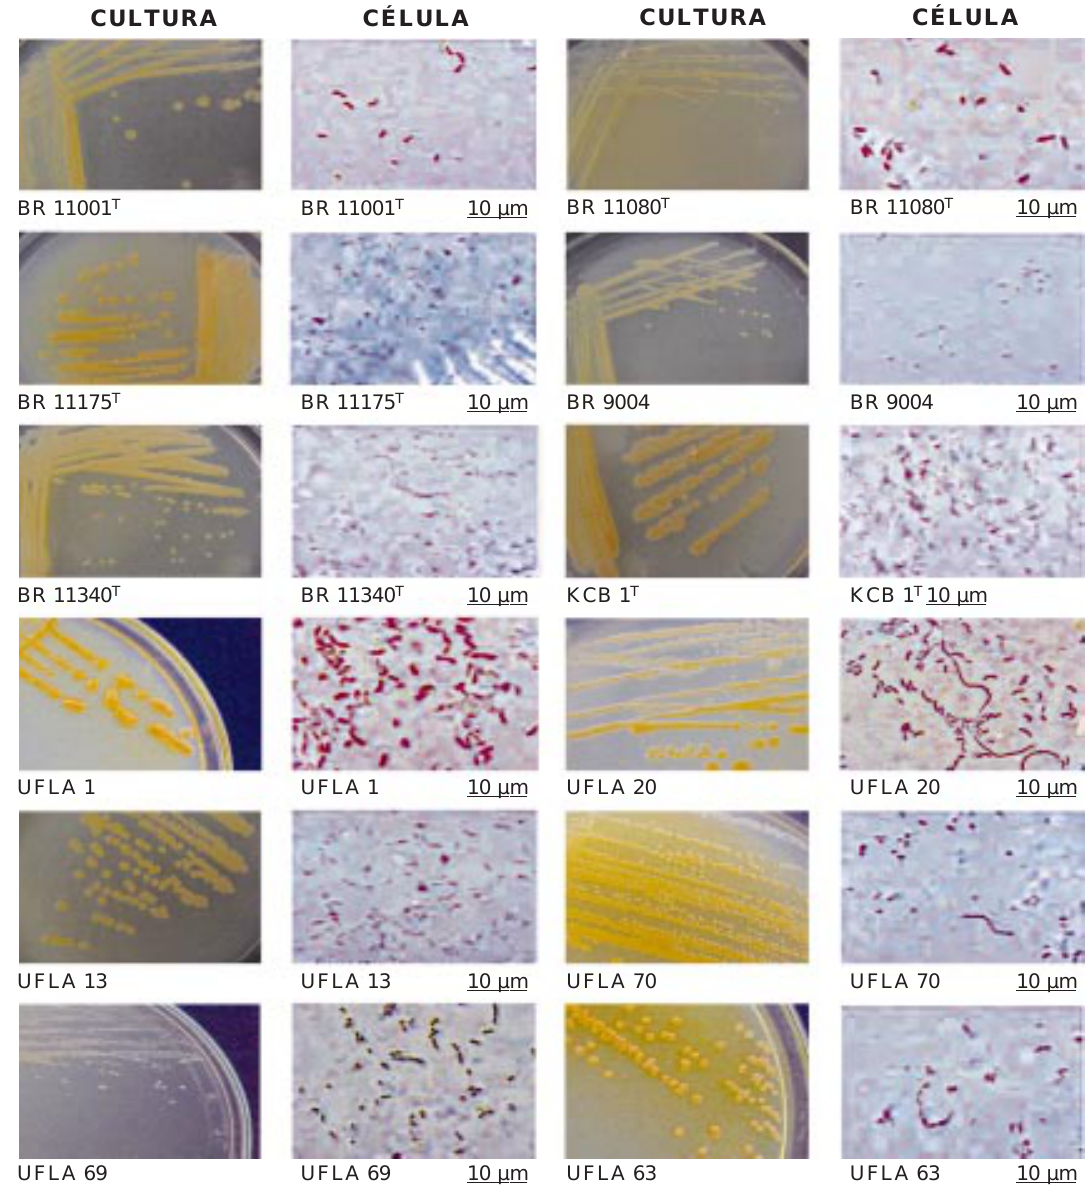
Figura 2. Aspectos morfológicos de colônias e de células de estirpe tipo e isolados representativos dos diferentes grupos encontrados em áreas reabilitadas após a mineração de bauxita em Poços de